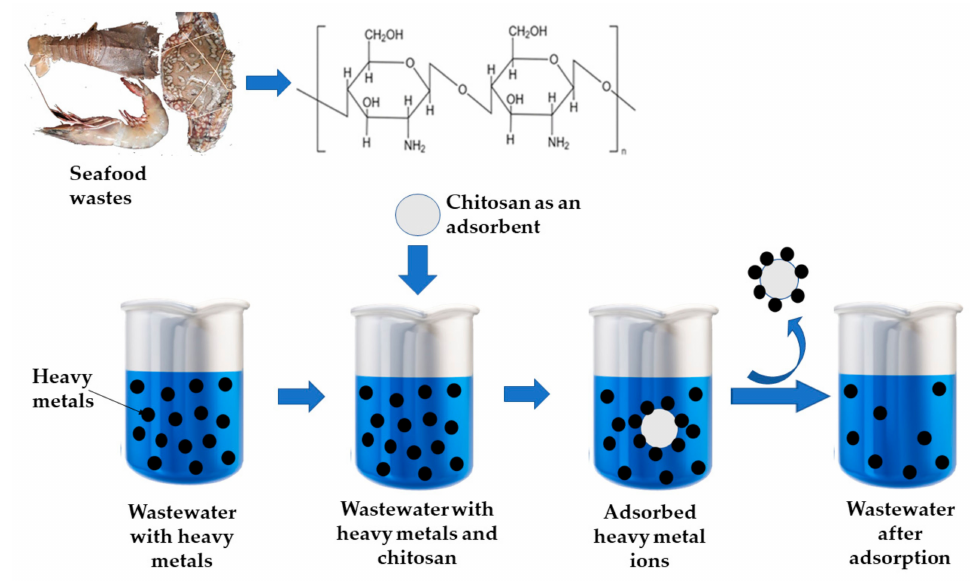
Figure 5. Chitosan is employed for removing heavy metals from